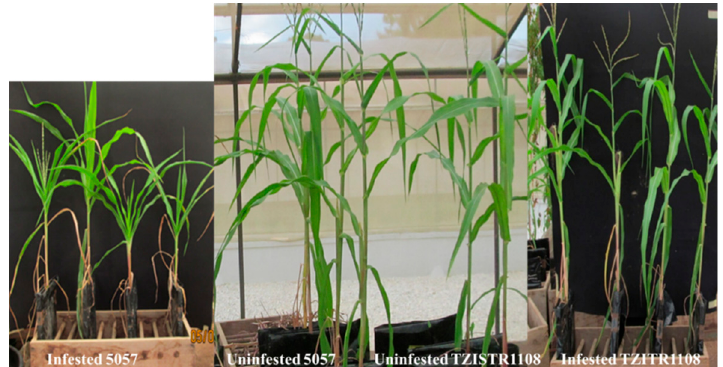
Figure 7. Infested and un ‐ infested 5057 and TZISTR1108 plants growing in rhizotron at 66 days after planting.